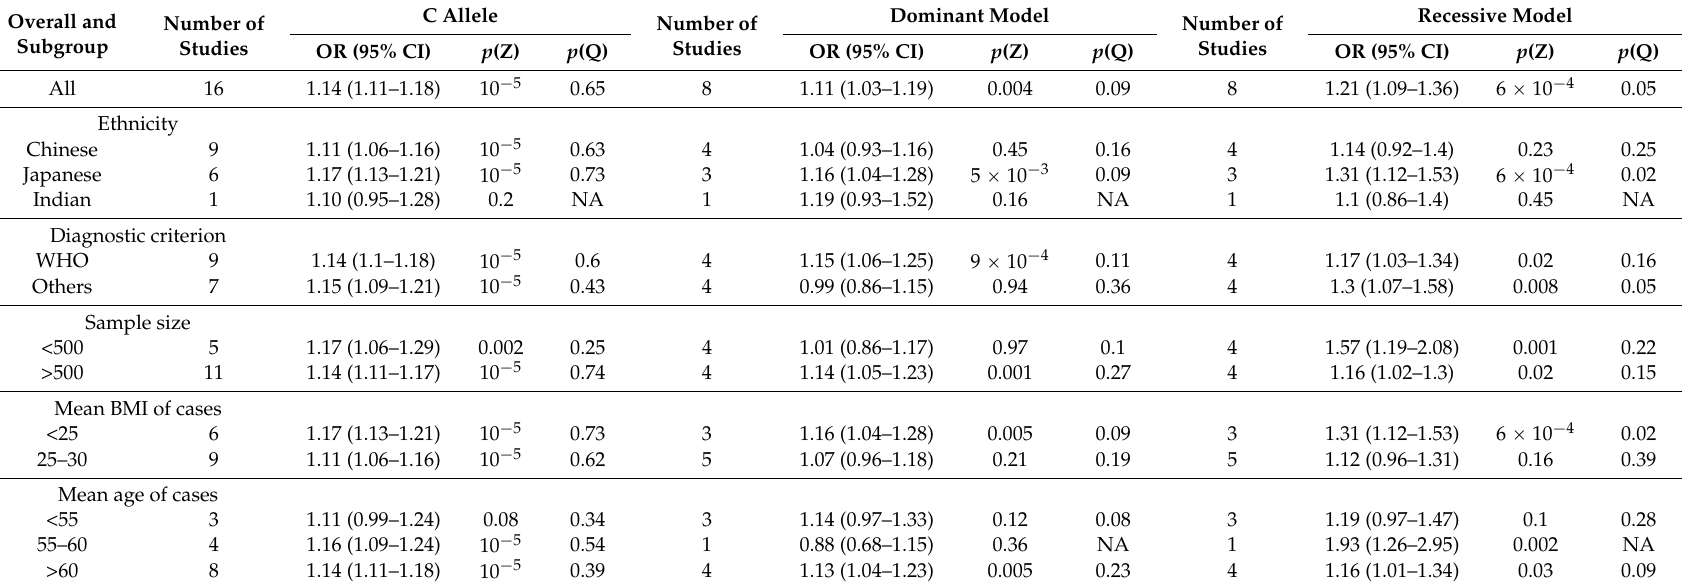
Table 4. Results of meta-analysis for IGF2BP2 rs1470579 polymorphism and